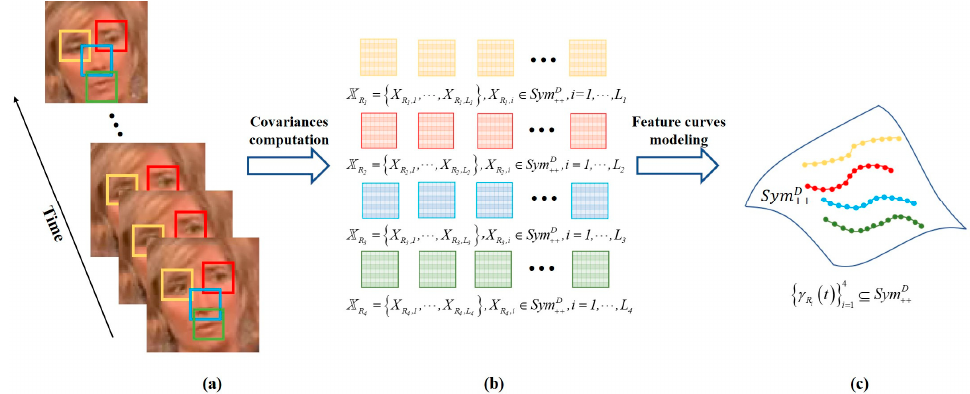
Figure 1. Overview of the proposed framework. Taking face video as example, the four boxes of red, yellow, blue, and green in ( a ) show the regions of interest (ROIs) on human face and time series of ROIs stringed through motion estimation. The regional covariance descriptors (RCDs) are computed for each region in ( b ). Hence, a family of feature curves on symmetric positive definite (SPD) manifold are built in ( c ).